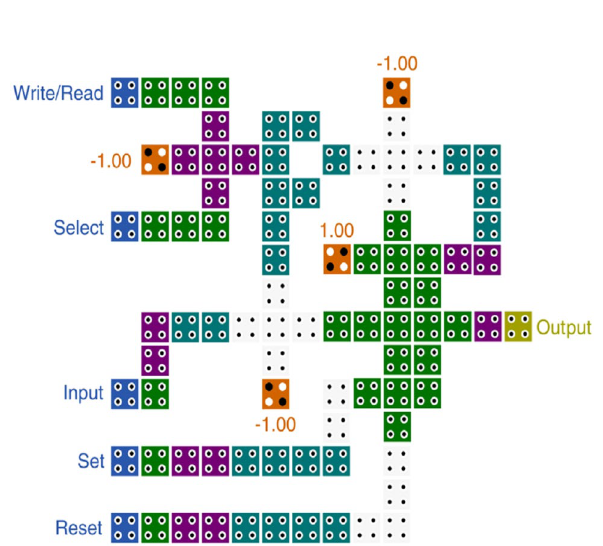
Fig. 5 The developed 1-bit RAM circuit in